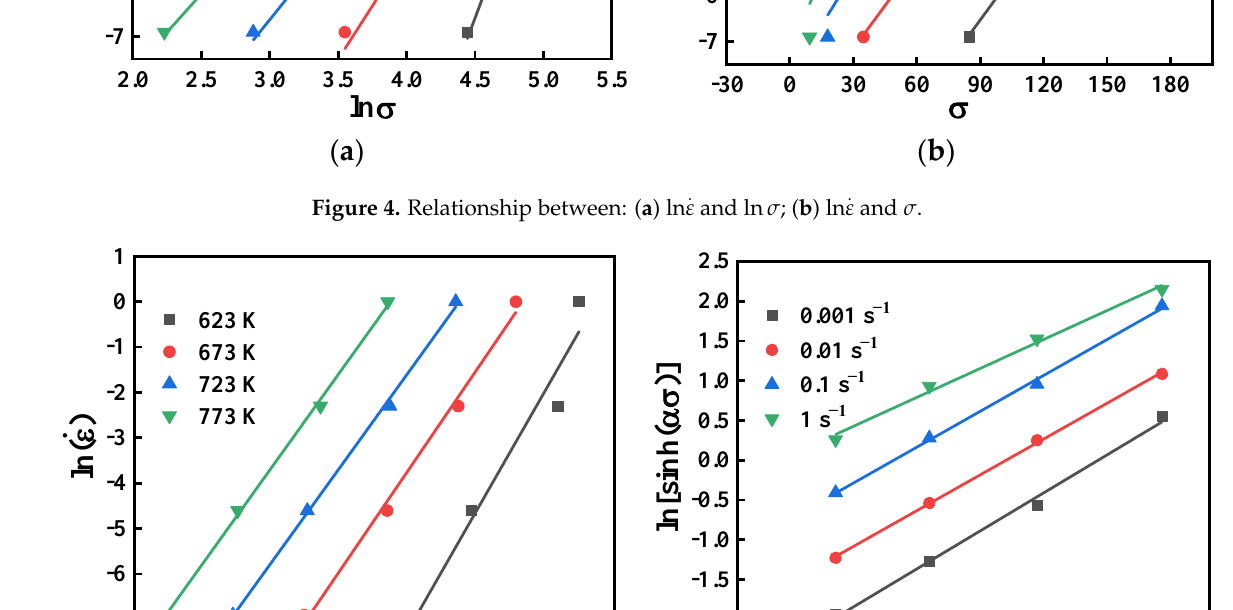
In order to calculate parameter A, the Zener–Hollomon parameter ( Z ) is utilized,